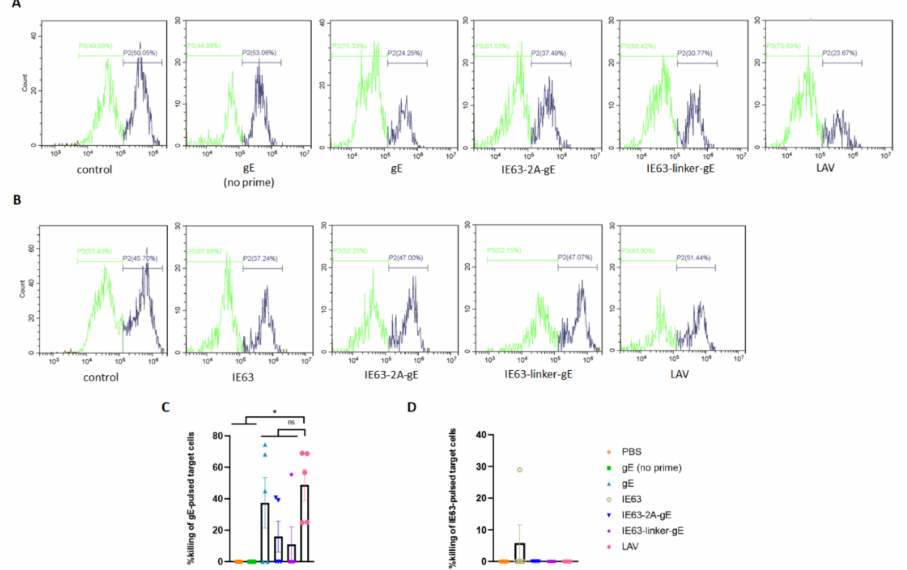
Figure 5. Cytotoxic activity of splenocytes derived from immunized mice. Antigen-specific cytotoxic activity of splenocytes derived from immunized mice on day 42 at effector-to-target ratios of 50:1. ( A ) Representative histograms of CFSE low (unpulsed, green) and CFSE high (gE pulsed, gray) popula- tions, 8 h after incubation with splenoctyes from immunized mice. ( B ) Representative histograms of CFSE low (unpulsed, green) and CFSE high (IE63 pulsed, gray) populations, 8 h after incubation with splenoctyes from immunized mice. ( C ) Killing ratio of the gE-pulsed target cells. ( D ) Killing ratio of the IE63-pulsed target cells. * p < 0.05, ns, no significant difference. Data represent mean ± SEM ( n =